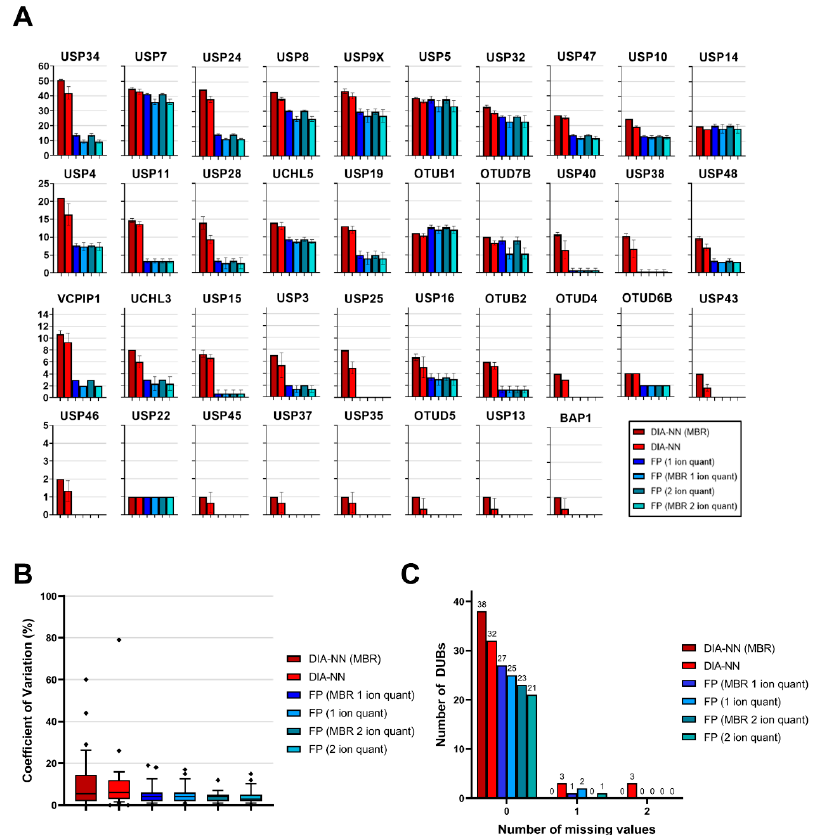
Figure 2. ( A ) Reproducibility and repeatability of Fragpipe and DIA-NN for ABPP-HT data. Mean number of peptides from quantified DUBs. For all DIA-NN searches, proteotypic peptides with in- tensities > 0 were counted. For all Fragpipe searches, unique peptides with intensities > 0 were counted. ( B ) CVs for DUBs quantified from DIA-NN and Fragpipe searches, upper and lower whisker limits represent CVs within the 10–90th percentiles. Outliers denoted as symbols. ( C ) Num- ber of missing values for DUBs quantified from DIA-NN and Fragpipe searches. MBR = match- between-runs, FP =